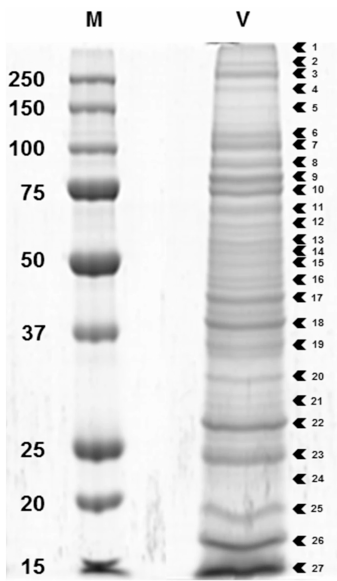
Figure 11. Coomassie Brilliant Blue G250 stained, SDS-PAGE of H. nigricans venom extract with known molecular weight protein ladder on left, showing numbered protein bands that were analysed separately. Left hand lane (M) shows protein molecular weight markers, right hand lane shows venom (V) proteins. (Source from [51] under the terms of Creative Commons Attribution Licence CC-BY 4.0 via BMC Genomics ).